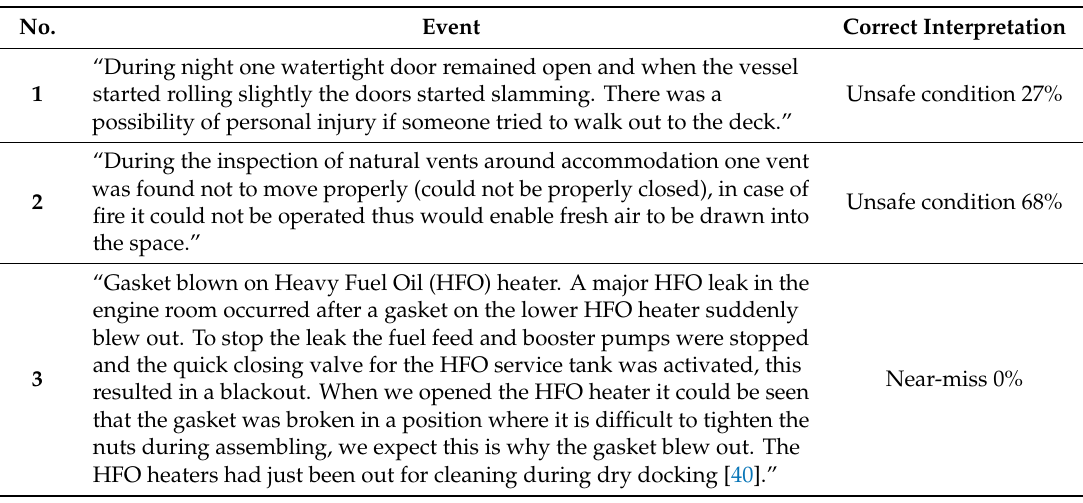
Table 8. Correct interpretation of events from the second